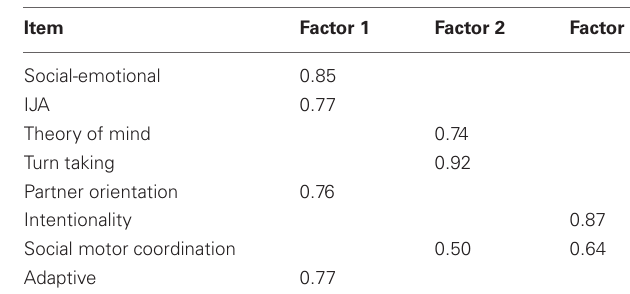
Table 5 | Results of the principal components